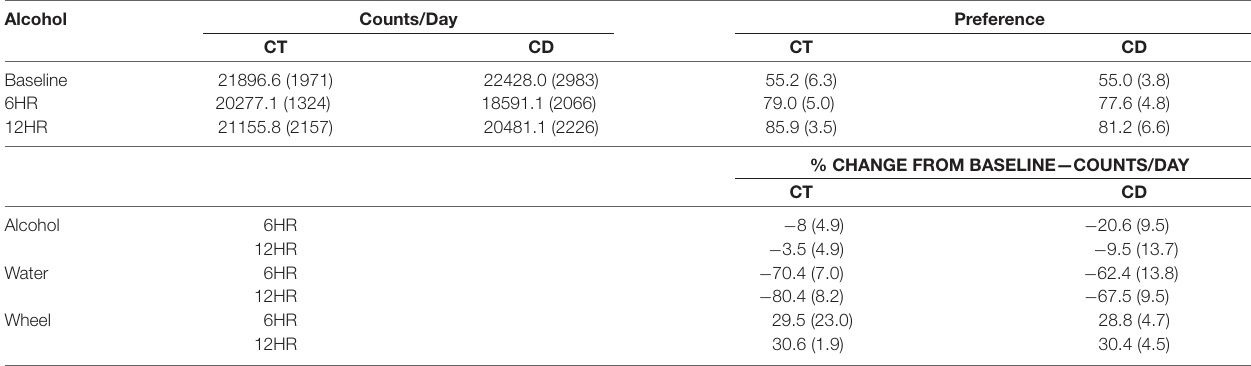
TABLE 1 | Analysis of overall alcohol lick counts and bottle preference during baseline alcohol access and 6 h (6HR) environmental CD.